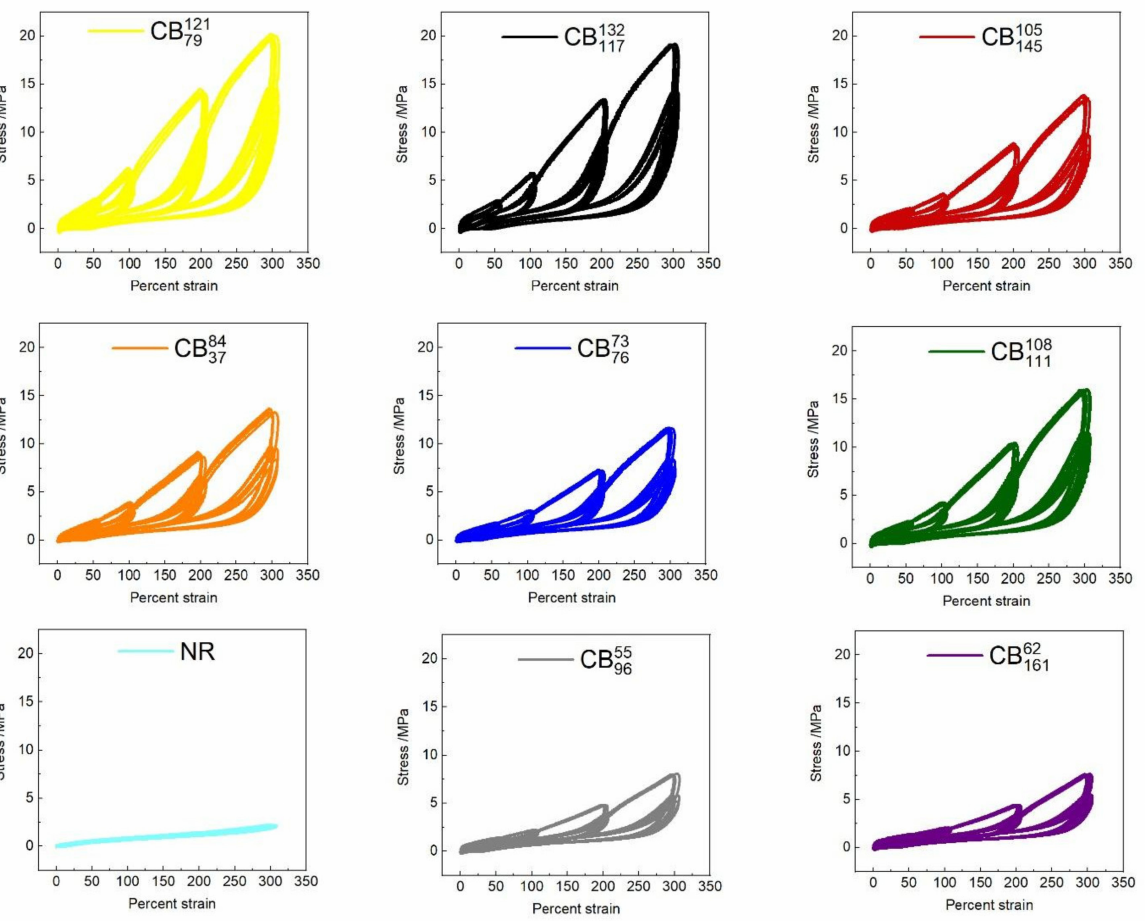
Figure 3. Stress–strain data, showing cyclic tensile test effects of the various rubber